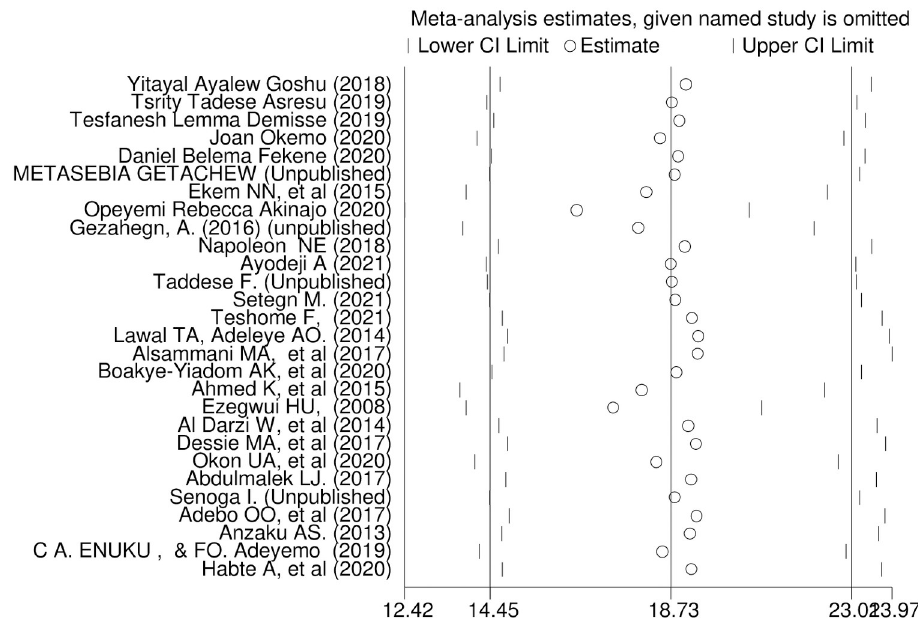
Fig 5. Sensitivity analysis of pooled prevalence for each study being removed one at a time.